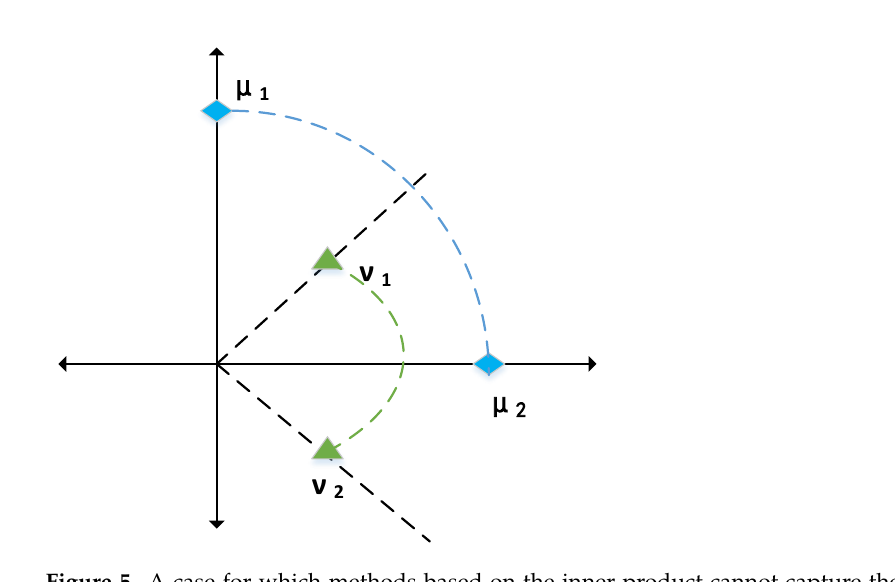
Figure 5. A case for which methods based on the inner product cannot capture the relationship between nodes. As we can see, the relationship between u 1 and u 2 and the relationship between node v 1 and v 2 can not be